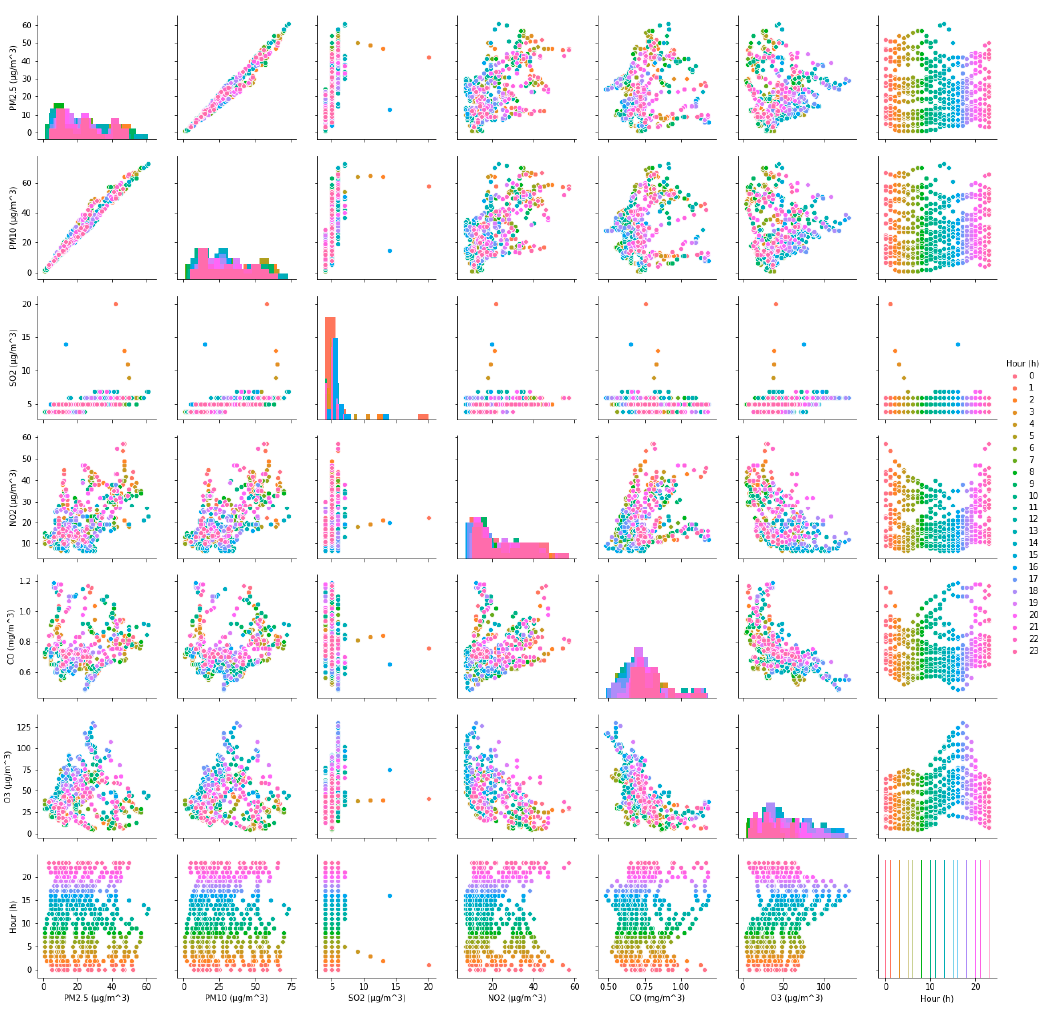
Figure 6. The pollutant concentrations distribution in case two.